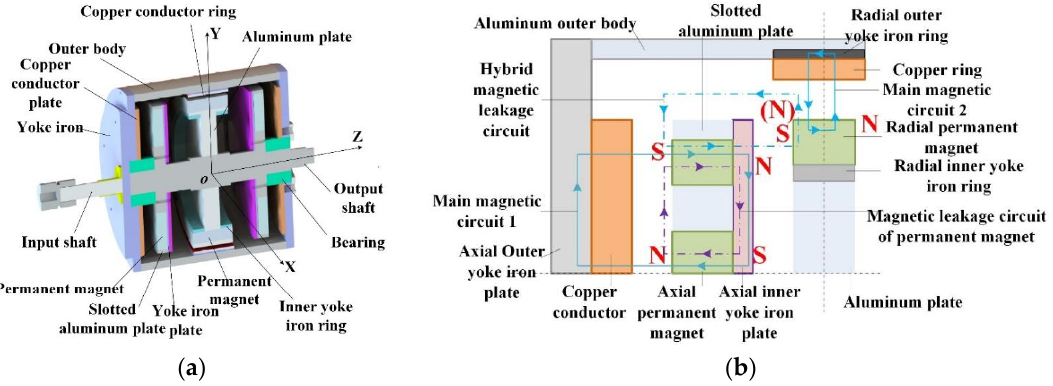
Figure 1. Hybrid magnetic coupler: ( a ) Schematic diagram of hybrid magnetic coupler; ( b ) Magnetic circuit diagram of hybrid magnetic coupler.